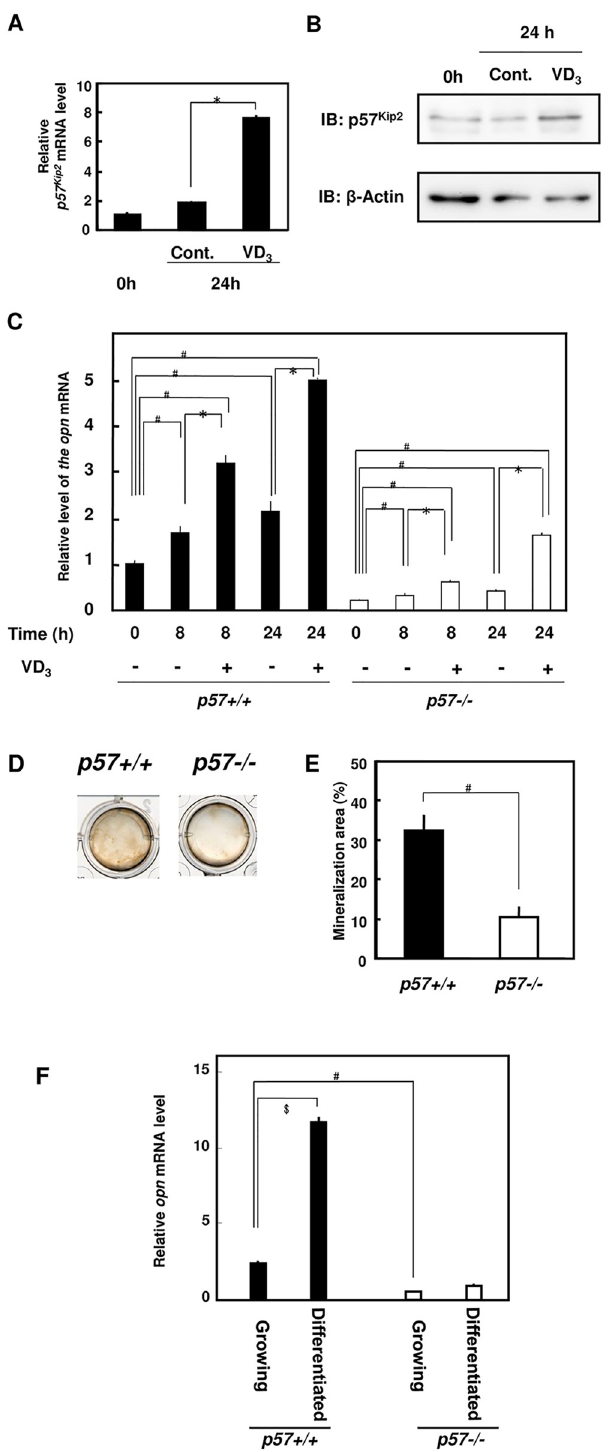
Fig 3. Effects of the ablation of p57 Kip2 on primary cultured osteoblasts. (A) Results of the quantitative RT-PCR analysis of p57 Kip2 transcripts. The results were normalized to hprt levels. An asterisk indicates a statistically significant difference: � , p < 0.01. (B) Immunoblot showing the levels of p57 Kip2 . In A and B, cells were treated with the vehicle (0.1% ethanol: Cont.) or 10 nM 1,25-(OH) 2 VD 3 (VD3) for 24 h. (C) The effect of 10 nM 1,25-(OH) 2 VD 3 on the expression of the osteopontin mRNA was analyzed using quantitative RT-PCR. The results were normalized to the hprt